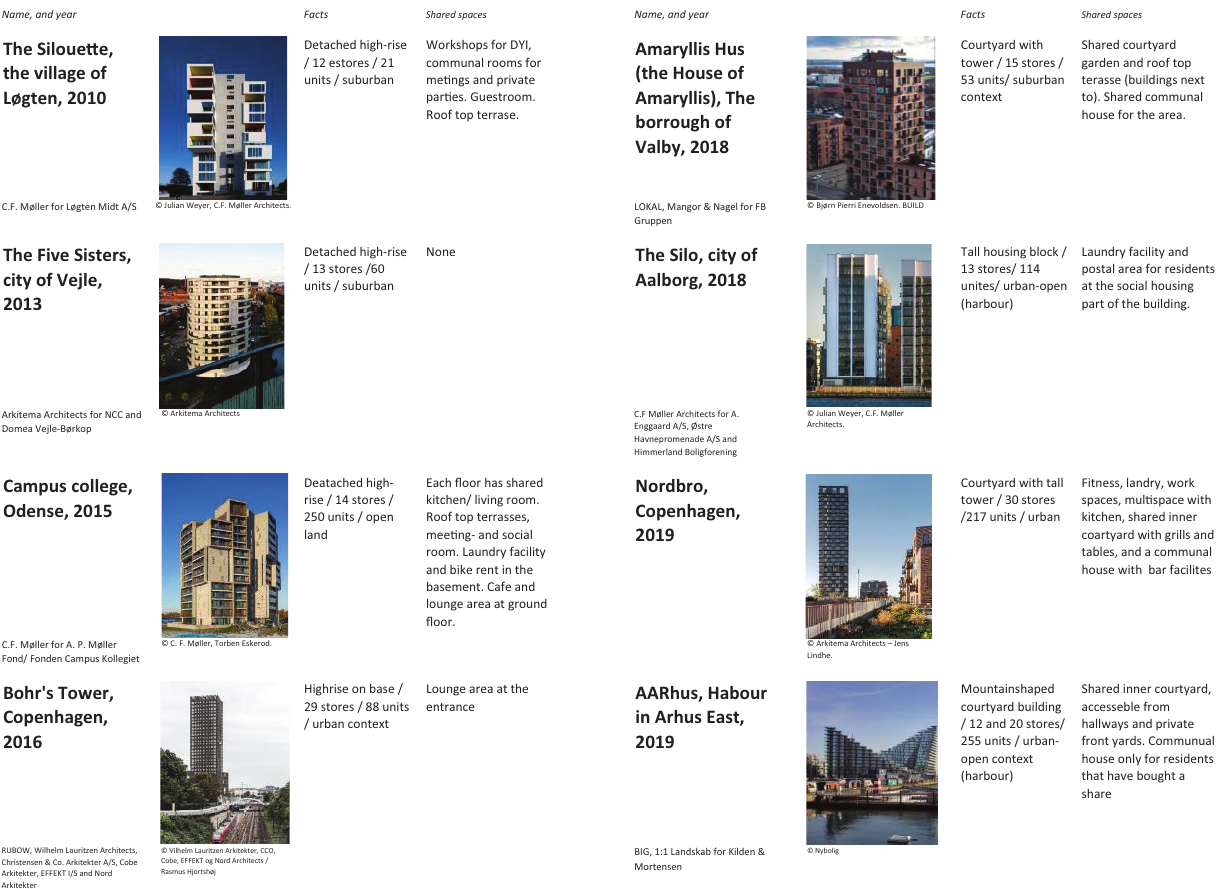
Figure 1. Description of the eight case studies. This article is based on more than 50 interviews with residents in eight newly built Danish high‐rises with various kinds of shared spaces, functions, and facilities. Source: Translated and edited from Mechlenborg and Hauxner (2021, pp.